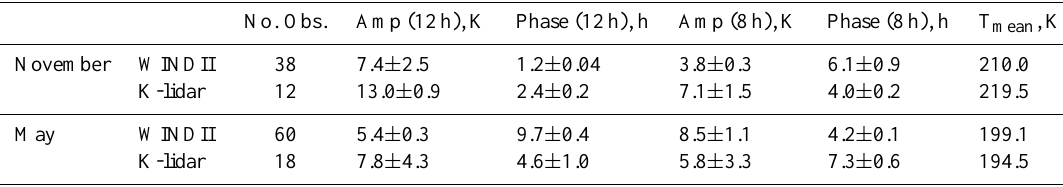
Table 2a. Temperature tidal-fit parameters at 28 ◦ N and at 89km height.